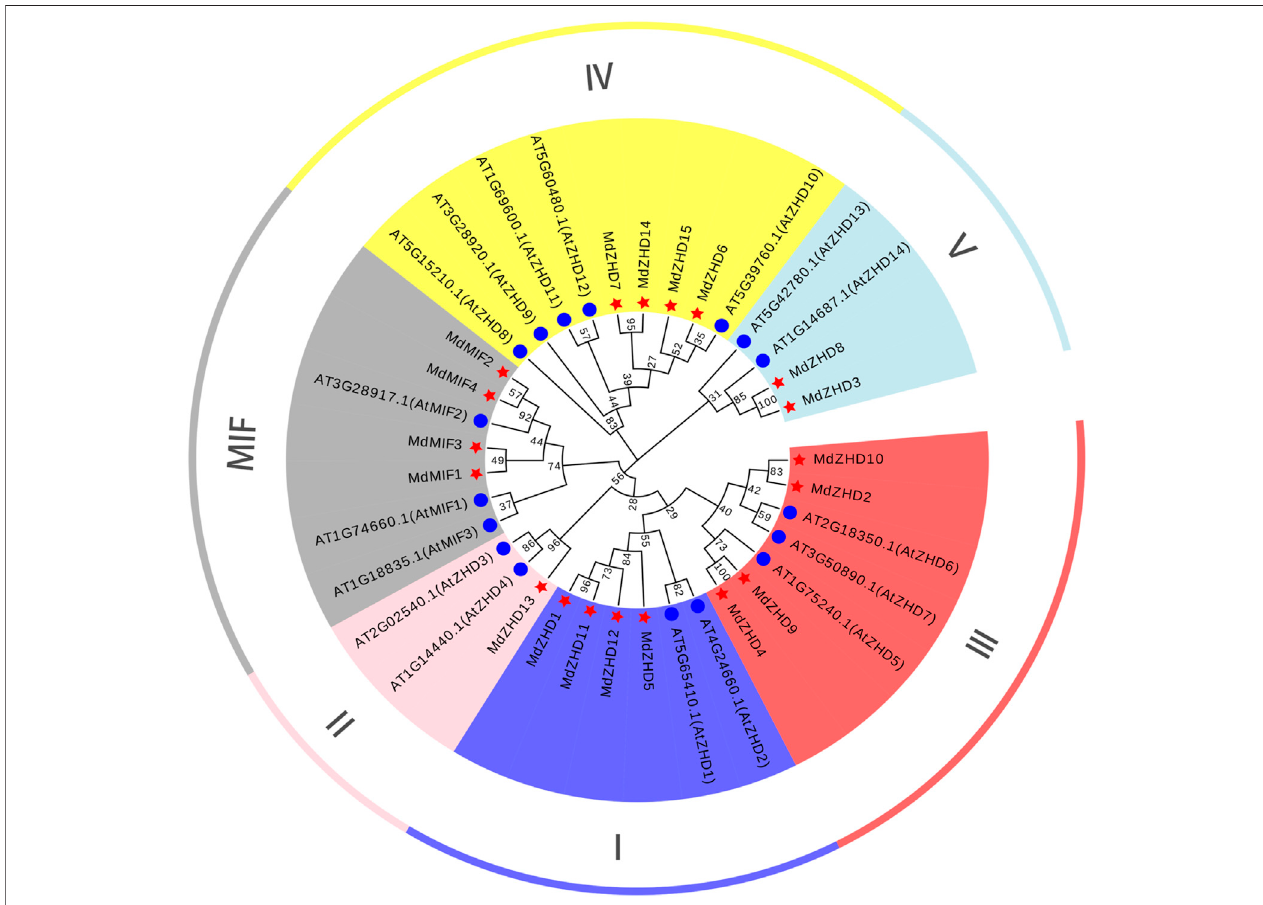
FIGURE 1 | The phylogenetic tree of ZF-HD proteins from apple ( Malus domestica , MdZHD) and Arabidopsis ( Arabidopsis thaliana , AtZHD). The tree was constructed by the Neighbor-joining (NJ) method using a MEGAX software with 1000 bootstrap replications. The MdZHD member was accompanyed with a red pentagram. Six subfamilies were identi fi ed in apple and were distinguished in different color: ZHD I, ZHD II, ZHD III, ZHD IV, ZHD V, and mini zinc fi nger (MIF).